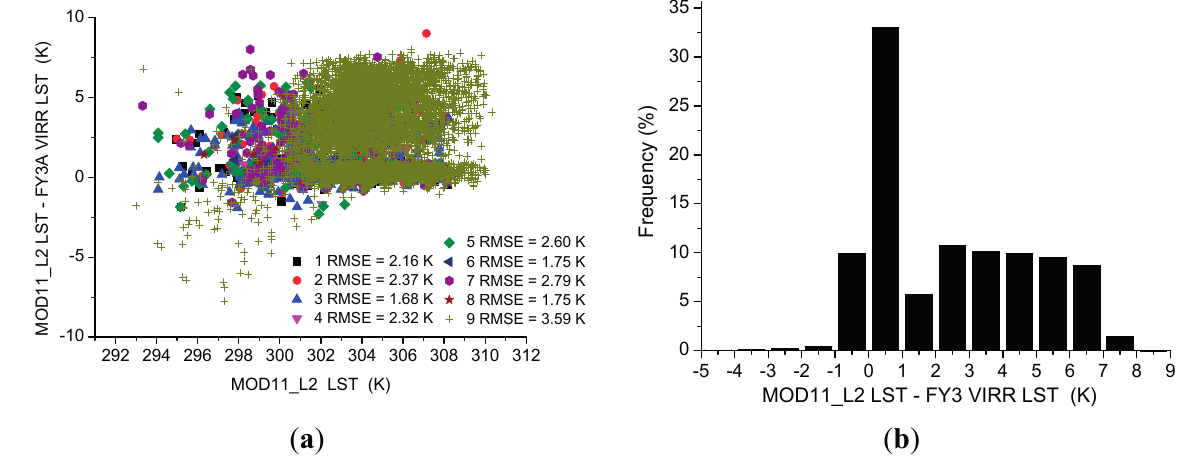
Figure 11. Comparison of two LSTs: ( a ) the difference between MOD11_L2 and VIRR LSTs as a function of MOD11_L2 LST; and ( b ) the corresponding histogram of the LST differences (1, cropland/natural vegetation mosaic; 2, croplands; 3, grassland; 4, open shrub land; 5, permanent wetlands; 6, savannas; 7, urban and built-up land; 8, woody savannas; 9, barren or sparsely